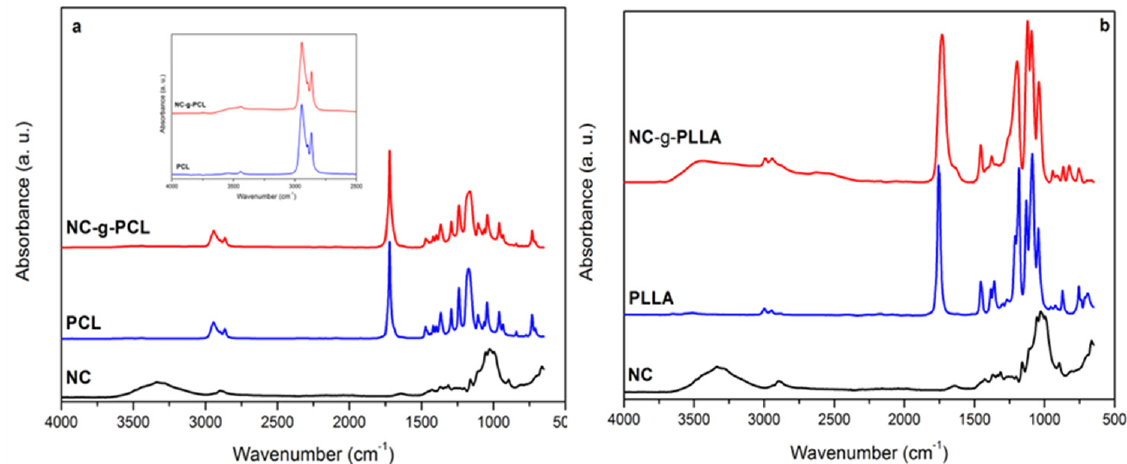
Figure 5. FT-IR spectra for: neat cellulose NC, PCL, and NC-g-PCL ( a ), and NC, PLLA, and NC-g- PLLA ( b ).